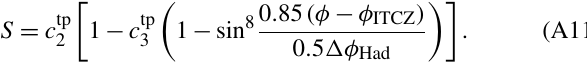
Figure 28. Last glacial maximum annual mean zonal near-surface air temperature differences relative to pre-industrial compared to PMIP3/4 models (Kageyama et al.,